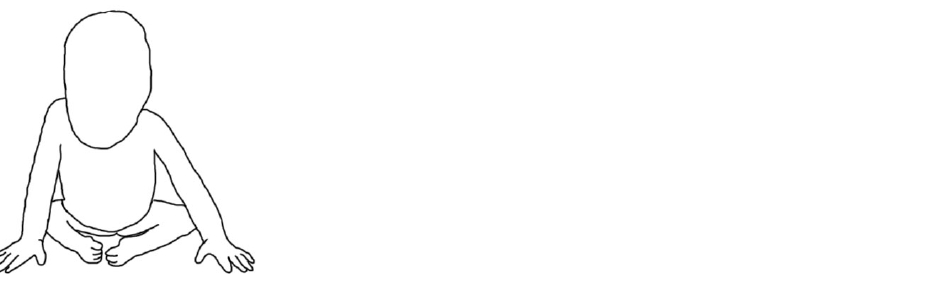
Figure 2. Typical sitting position of a child with complete absence of sacrum and some lumbar vertebra.